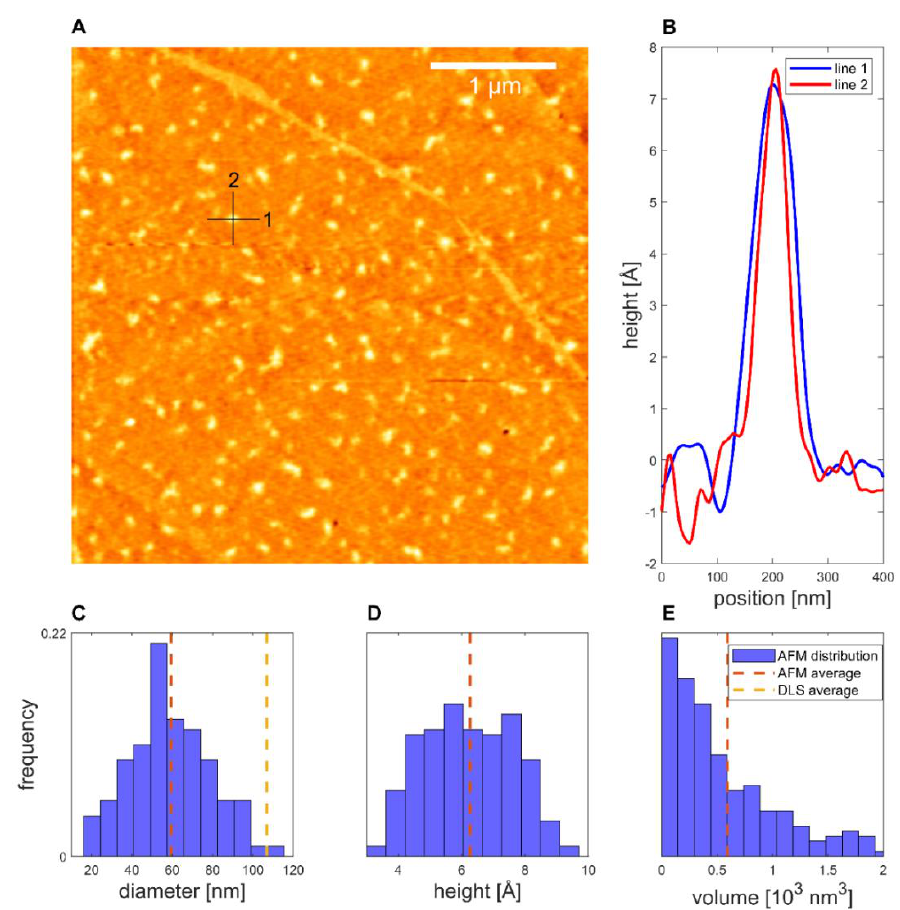
Figure 6. The 1:20-NPs deposited on HOPG. ( A ) Topography. ( B ) Line profiles of a proticle. ( C ) Equivalent diameter distribution. ( D ) Height distribution. ( E ) Volume distribution ( N = 200).